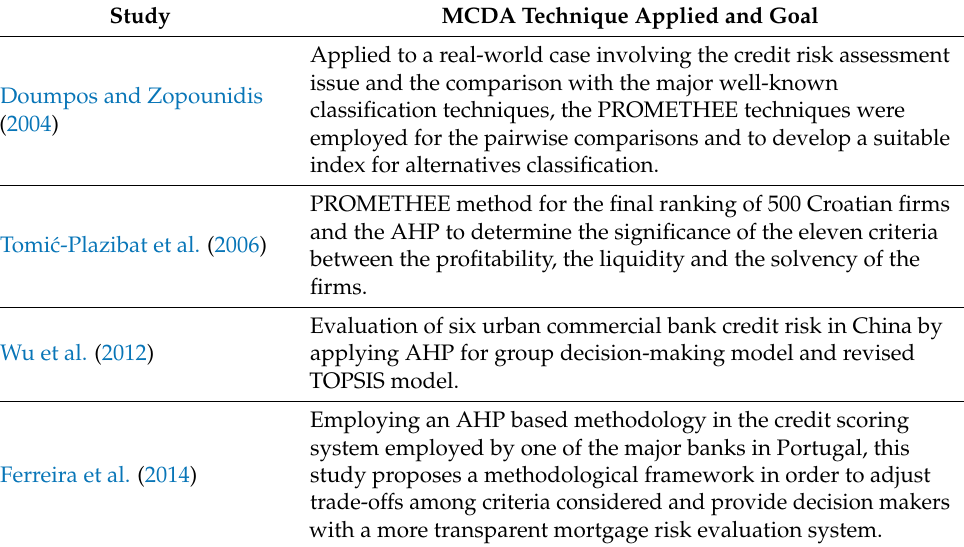
Table 1. Scientific paper that employ AHP, PROMETHEE, and TOPSIS for credit risk assessment